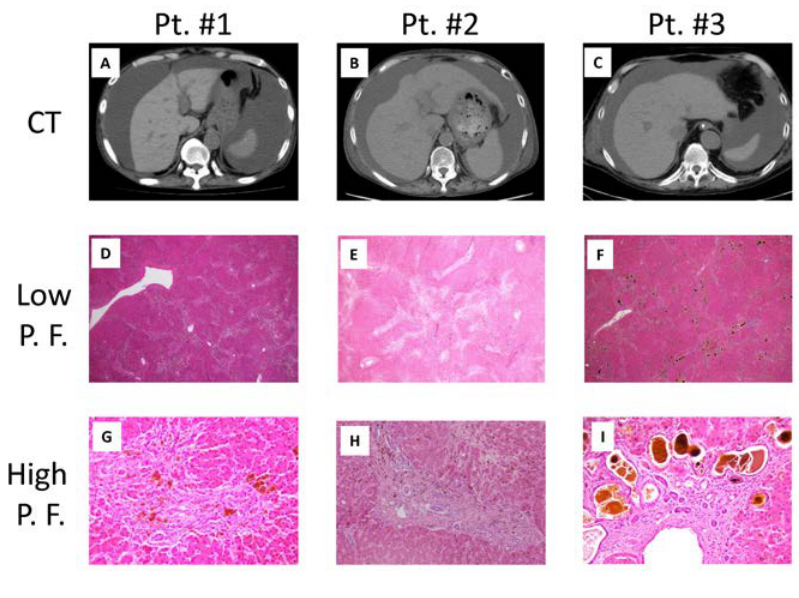
Figure 2. Computed tomography (CT) and pathological findings. A-C) CT images of the ascites and liver. D-F) Microscopic findings of the liver specimens at low-power field (20×). All specimens showed fibrosis in portal spaces. G-I) High-power field images (G,H: x200, I: 100×). Lymphocyte infiltration was not seen in all specimen. In patient 3, bile plug due to cholestasis was seen (I). A, D and G) patient no. 1; B, E and H) patient 2; C, F and I) patient no.